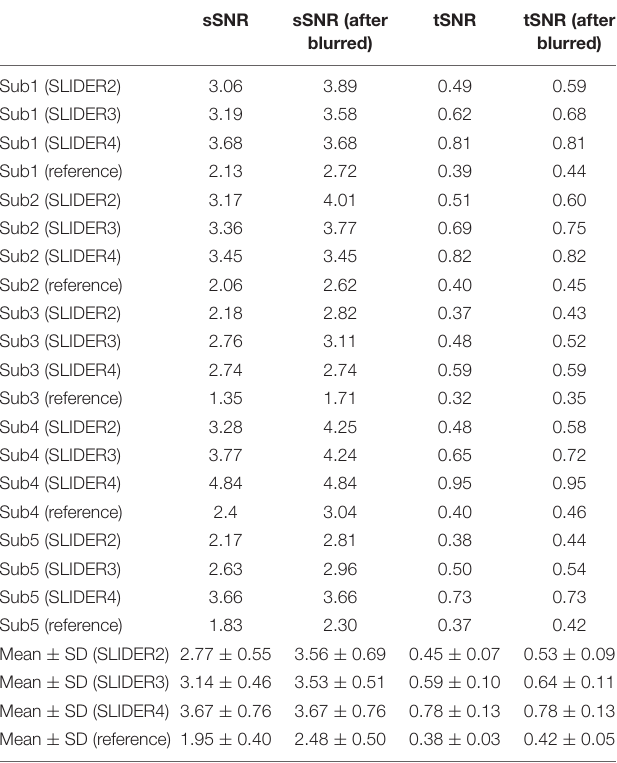
TABLE 1 | Spatial and temporal SNR of the super-resolution reconstructed images and reference images for all five subjects. sSNR sSNR (after tSNR tSNR (after blurred) blurred)